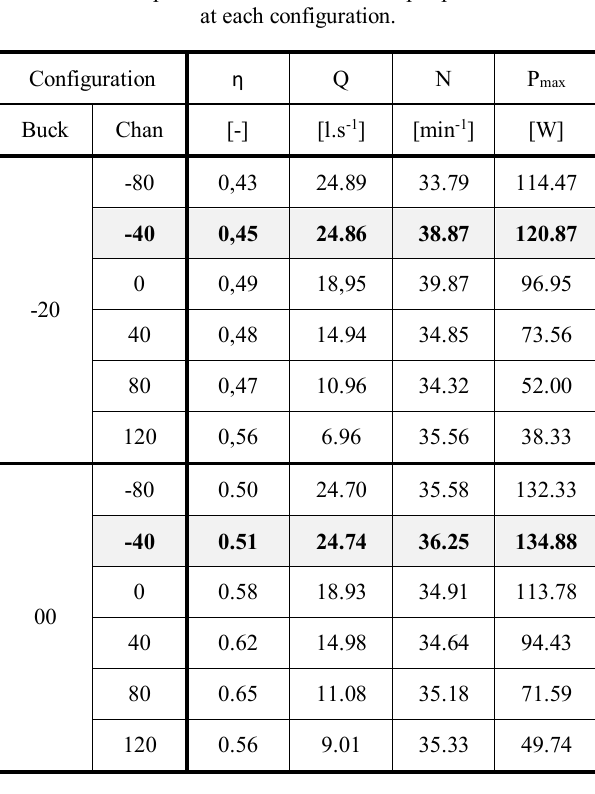
Fig. 9. Torque for configuration, bucket 00 and channel edge position -40 for different flow rates.